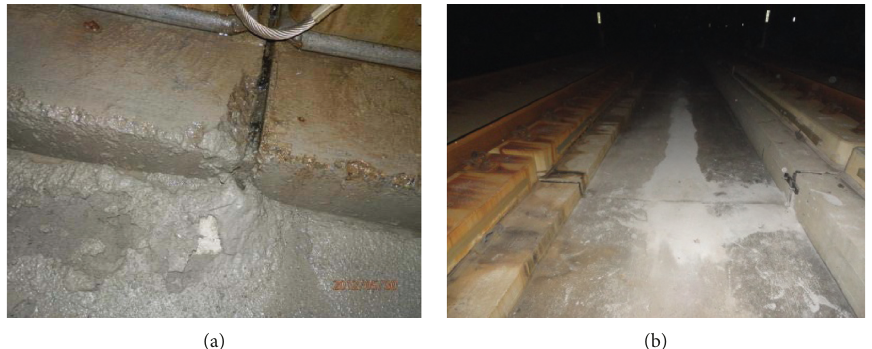
Figure 2: Mud pumping occurring in the slab